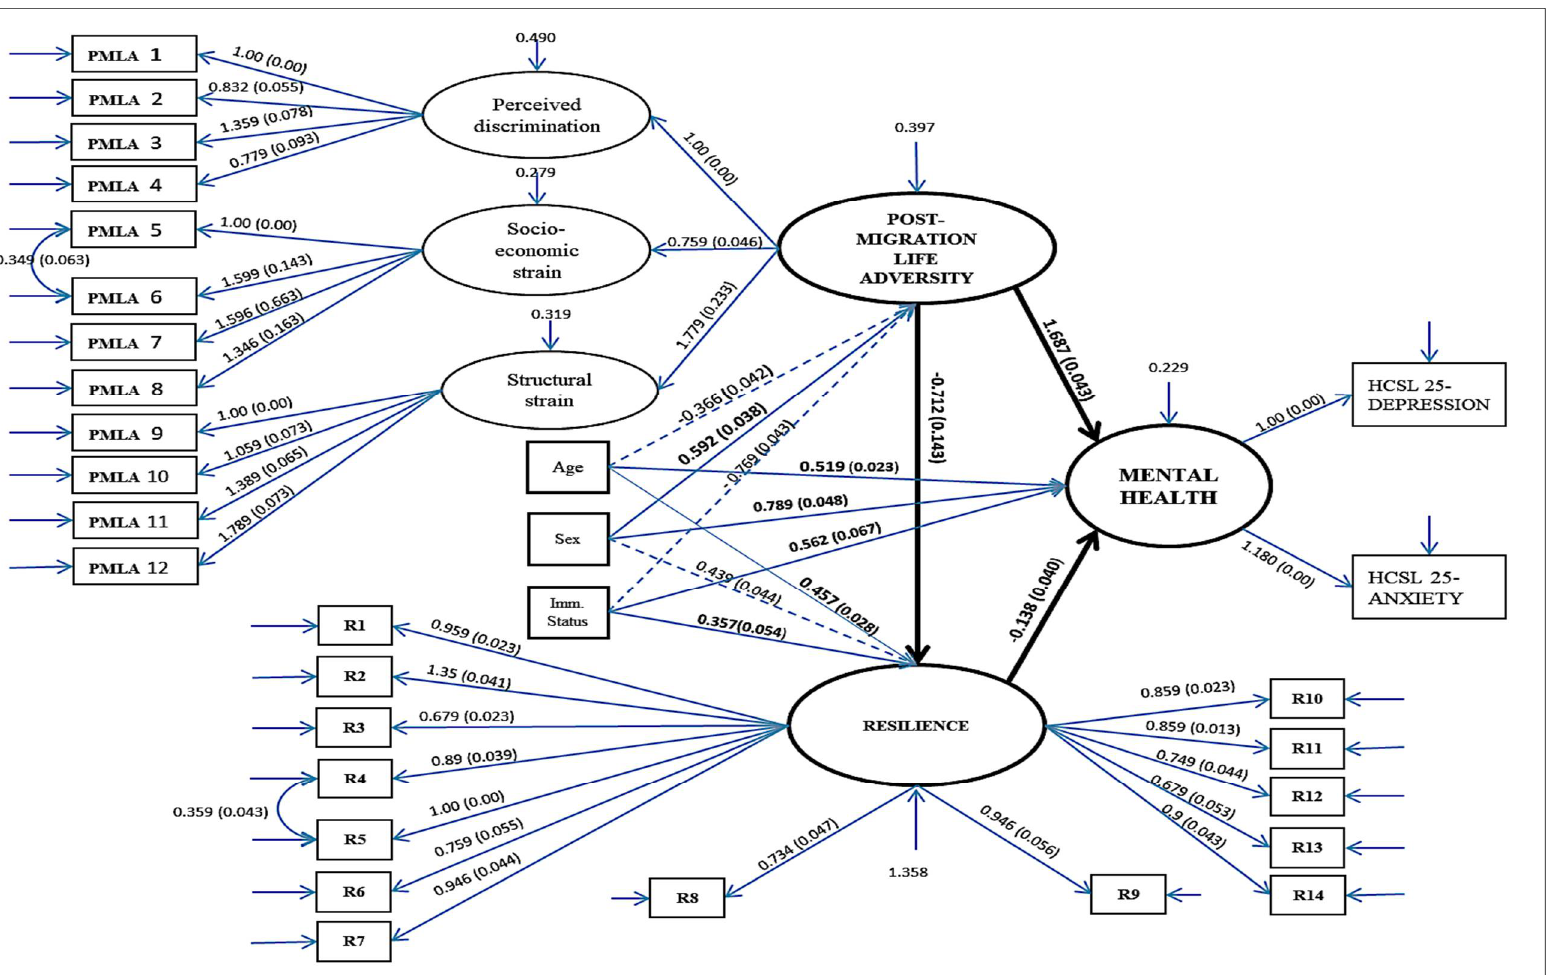
Figure 1. Full Structural Equation Model of Mental Health Problems (depression and anxiety) regressed on post-migration life adversity and resilience.